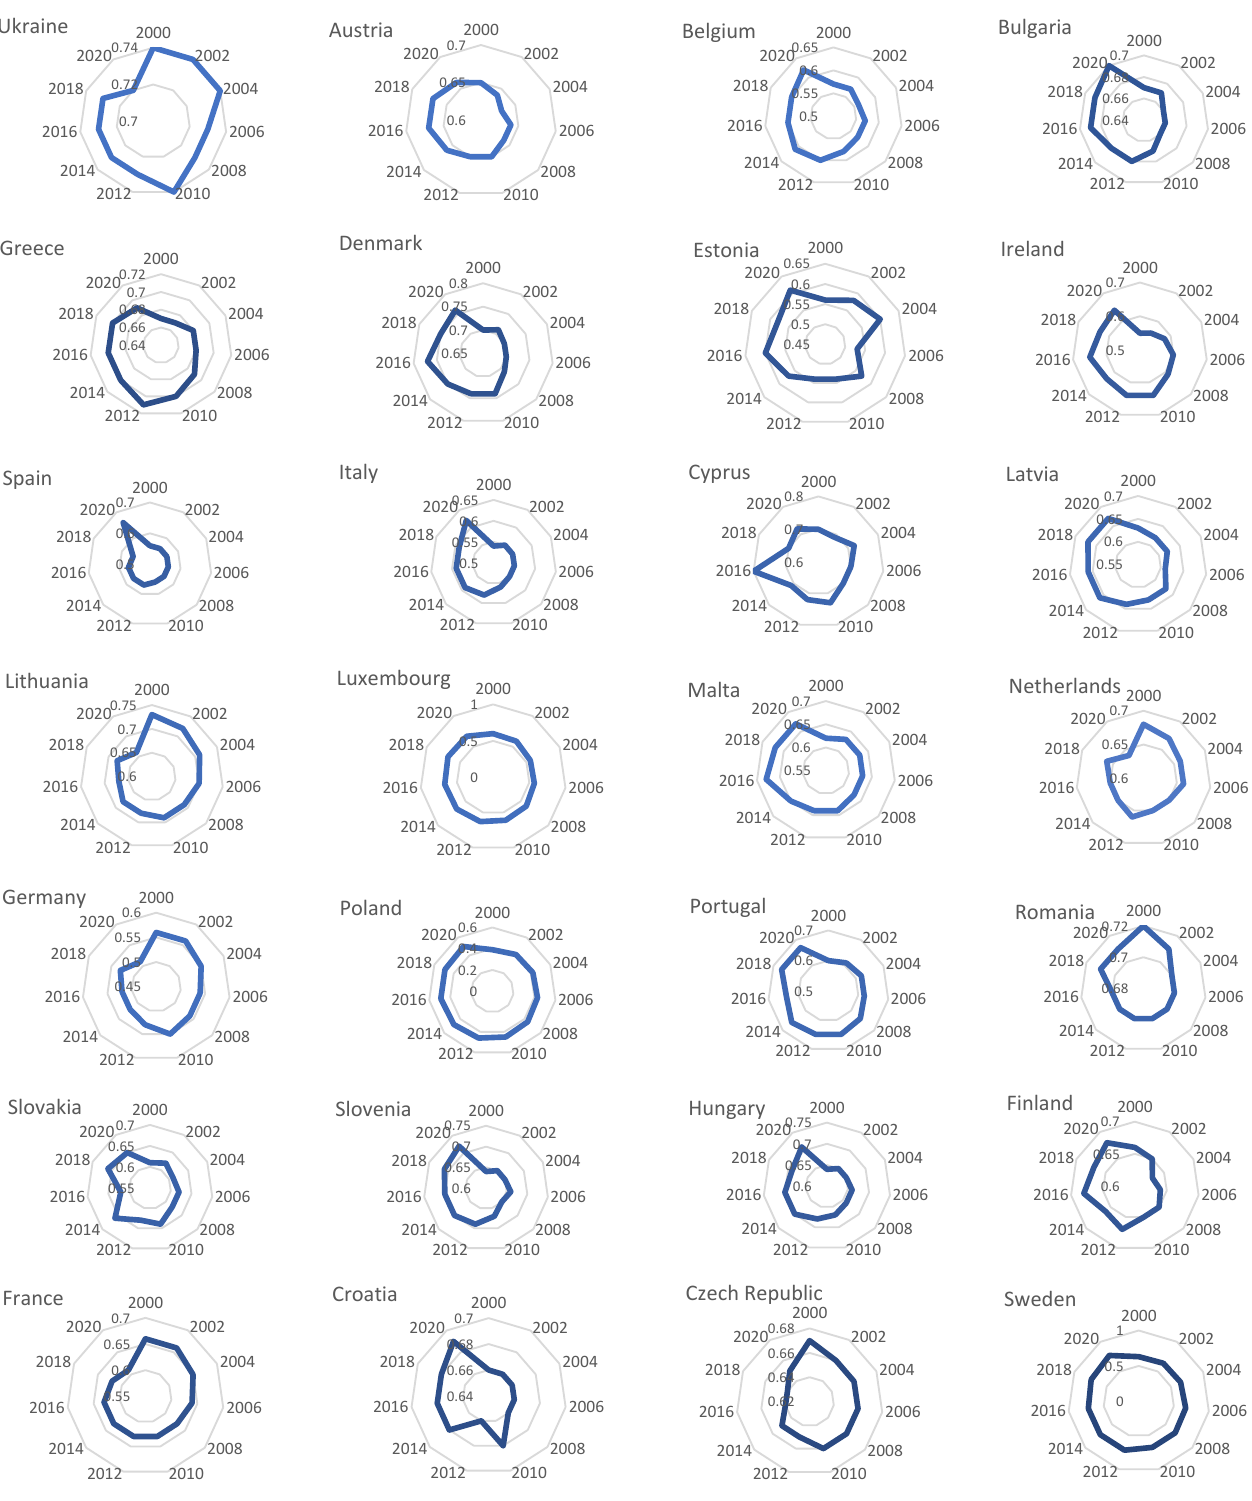
Figure A1. Results of calculating subindices of the convergent component of Ukraine and the EU countries, 2000 – 2020.